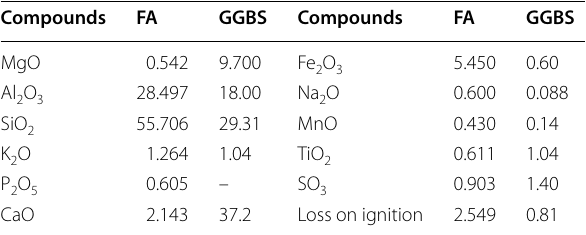
Table 1 Chemical composition (wt.%) of raw materials.